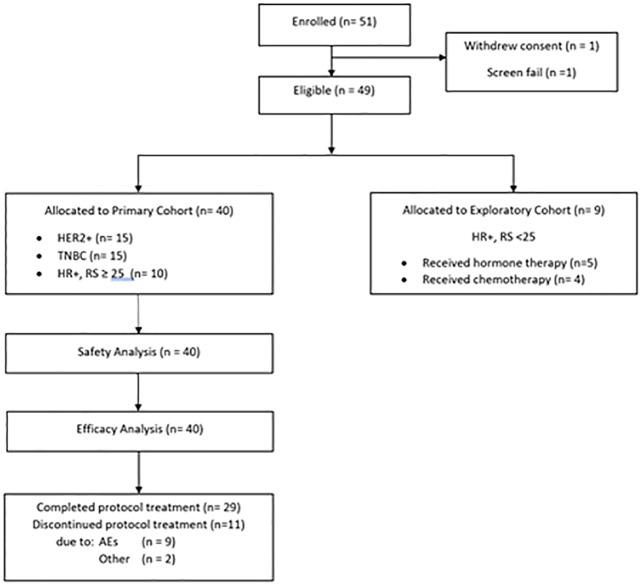
CONSORT flowchart.